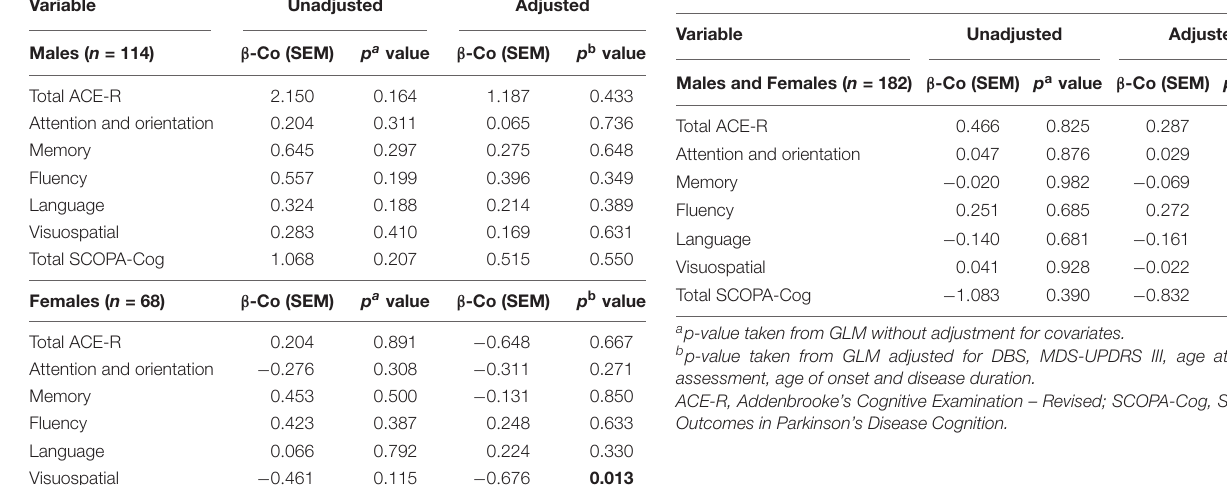
TABLE 5 | Cognitive performance in participants based on TRG levels, not separated by sex. Variable Unadjusted